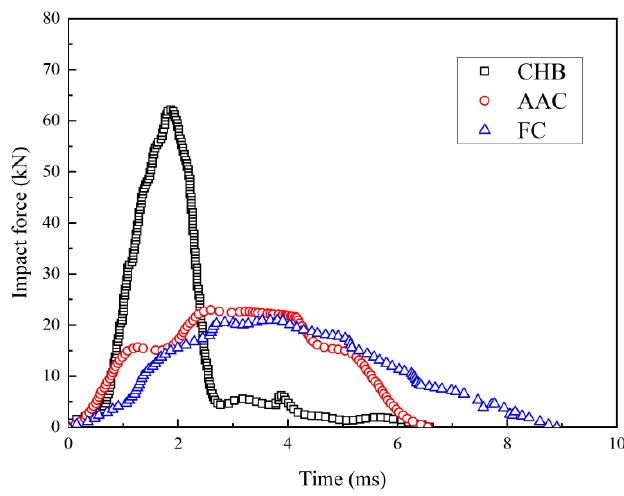
Figure 3. Evolution of impact force with time during drop-weight tests.